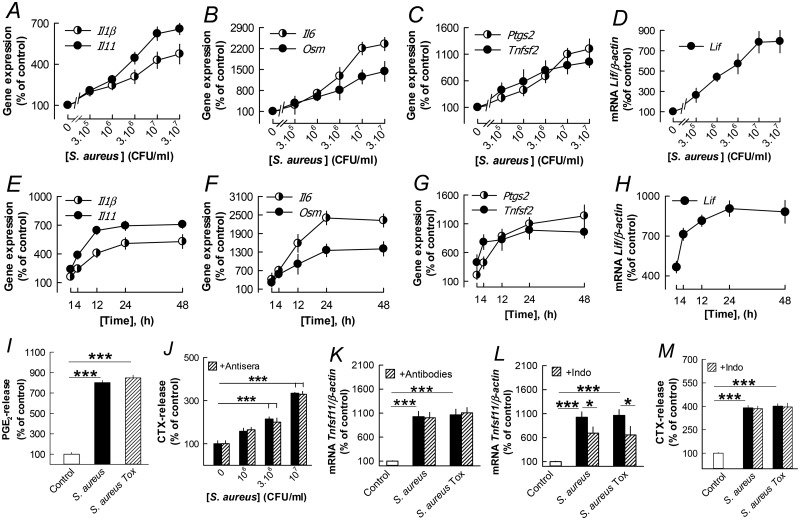
S. aureus stimulates bone resorption in mouse parietal bones independently on cytokine and prostaglandin production.(A-D) Concentration-dependent effect by S. aureus on Il1b, Il11, Il6, Osm, Tnfsf2 and Ptgs2 mRNA expression in parietal bones. (E-H) Time-dependent effect by S. aureus (3x106 CFU/ml) on Il1b, Il11, Il6, Osm, Tnfsf2 and Ptgs2 mRNA expression in parietal bones. (I) Stimulation of PGE2 release from the bones by S. aureus (3x106 CFU/ml). (J, K) The stimulatory effect by S. aureus (106–107 CFU/ml) on CTX- release and by S. aureus (3x106 CFU/ml) on Tnfsf11 mRNA expression in parietal bones was unaffected by adding a mixture of antibodies neutralizing IL-1β, IL-6, IL-11, LIF, OSM and TNF-α. (L, M) Indomethacin (1 μmol/l) partially reduced Tnfsf11 mRNA induced by S. aureus (3x106 CFU/ml) but did not affect CTX-release. Data are means of 5 (A-H, K, L) or 6 (I, J, M) observations and SEM is given as vertical bars when larger than the radius of the symbol. In Fig 3A, effects on Il11 (P<0.001) and Il1b (P<0.01) mRNA were statistically significant at 3 x 105–3 x 107 CFU/ml. In Fig 3B, effects on Il6 (P<0.001) and Osm (P<0.01) mRNA were statistically significant at 3x105–3x107 CFU/ml. In Fig 3C, effects on Ptgs2 mRNA were statistically significant (P<0.001) at 3x105–3x107 CFU/ml and on Tnfsf2 mRNA at 3x105 and 3x107 (P<0.001) and at 106–107 (P<0.01) CFU/ml. In Fig 3D, effects on Lif mRNA at 3x105 (P<0.05) and at 106–3x107 (P<0.01) CFU/ml were statistically significant. In Fig 3E, effects on Il1b and Il11 mRNA were statistically significant (P<0.001) at 4–48 h. In Fig 3F, effects on Il6 mRNA were statistically significant (P<0.001) at 1–48 h and on Osm mRNA at 1, 4, 24 and 48 h (P<0.001) and at 12 h (P<0.01). In Fig 1G, effects were statistically significant on Ptgs2 mRNA at 4–48 h (P<0.001) and on Tnfsf2 mRNA at 4, 24 and 48 h (P<0.001) and at 12 h (P<0.01). In Fig 3H, effects on Lif mRNA were statistically significant (P<0.001) at 1–48 h. ***P<0.001 compared to unstimulated control (I-M) or *P<0.05 to S. aureus stimulated bones (L).